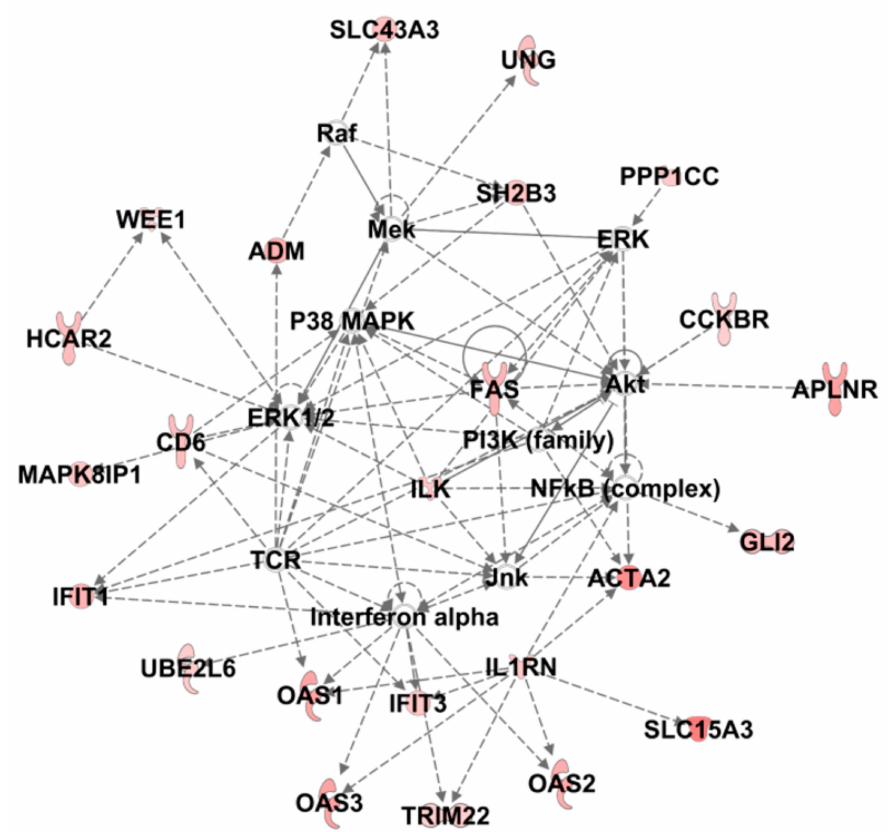
Figure 7. IPA analysis of the 128 significantly altered genes. The top-scoring regulatory network built from Core Analysis and named Dermatological Diseases and Conditions, Organismal Injury and Abnormalities, Immunological Disease is shown. Colored nodes are the genes of the dataset participating to the